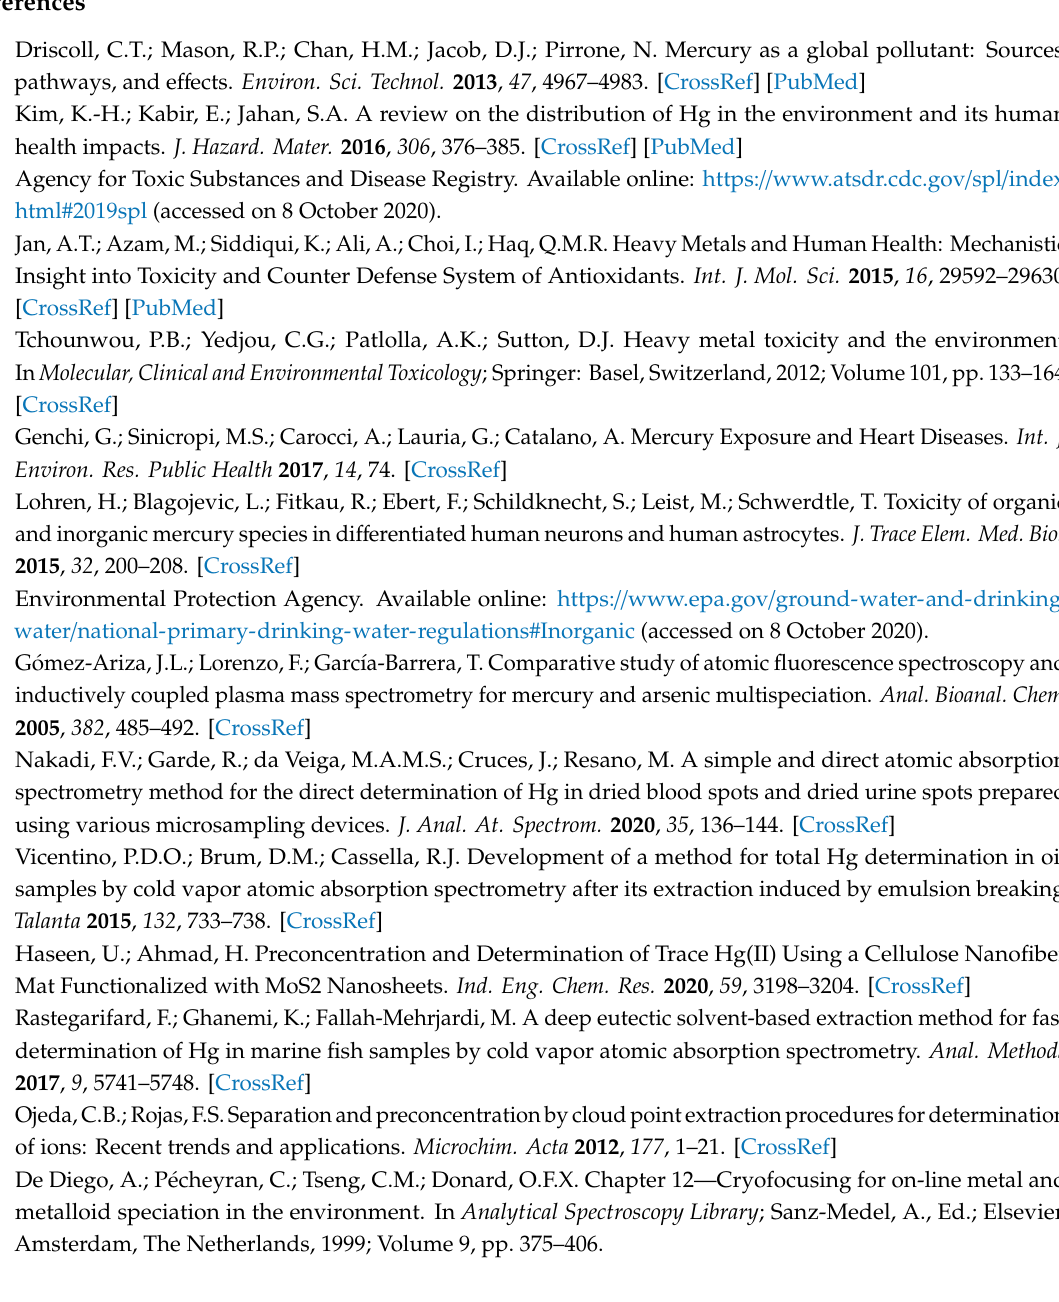
Figure S1: Zeta potential envelope of bare PANI and bare MoS 2 , Figure S2; ATR-IR spectra of PANI-MoS 2 before and after Hg(II) adsorption, Table S1: Solid phase extraction and preconcentration of trace Hg(II) in real samples analyses after to determine Hg(II) concentration by ICP-OES (column conditions: sample volume 250 mL, flow rate 8 mL min − 1 , eluent 5 mL HCl, sorbent amount 0.25